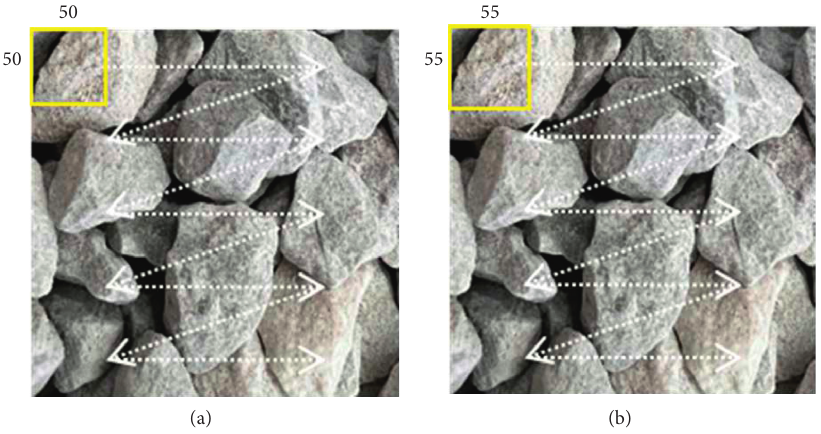
Figure 8: (a) The minimum sliding window; (b) the increment is 5